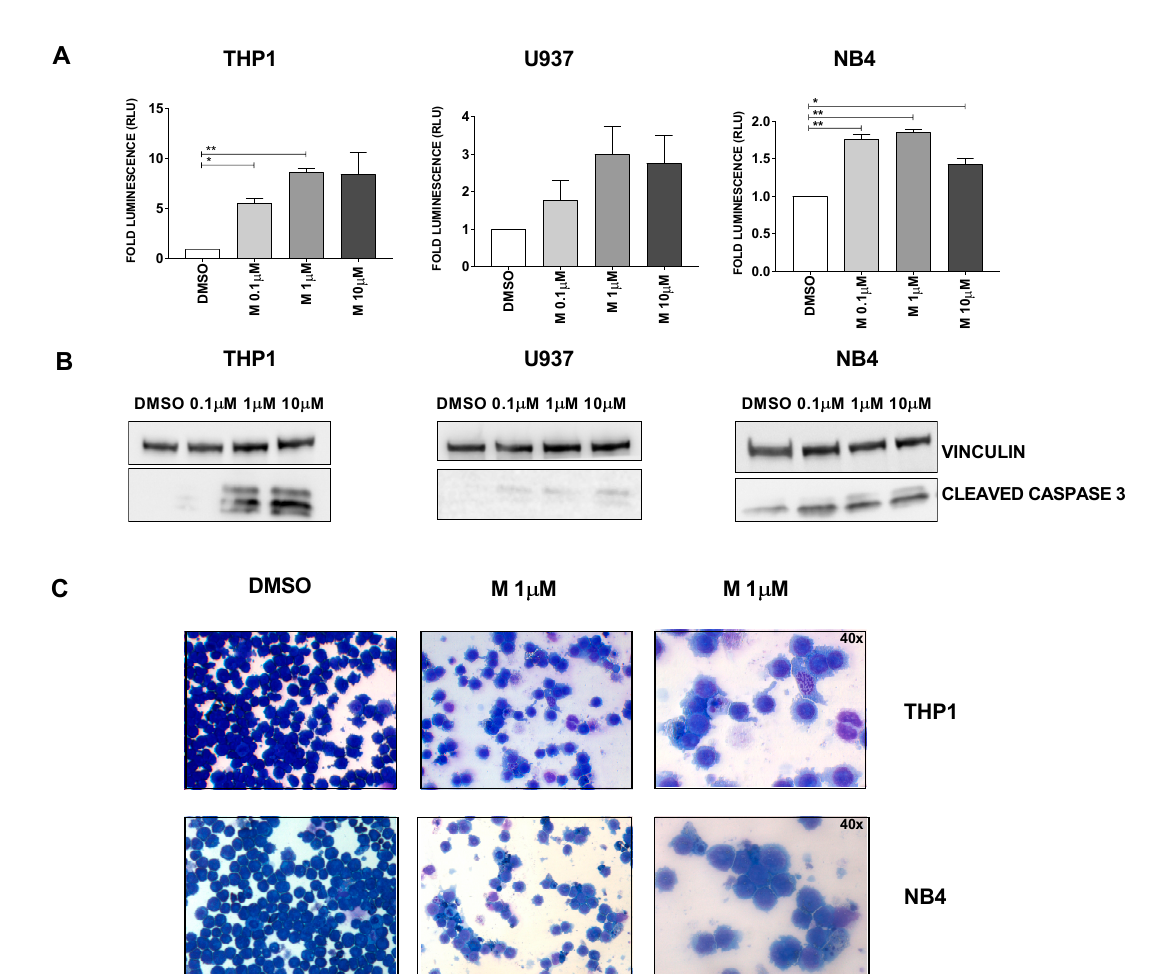
Figure 2. MEDS433 induces apoptosis in several AML cell lines (II). ( A ) MEDS433 treatment increases the activity of caspases 3/7, as evaluated through a specific functional assay ( n = 3). ( B ) MEDS433 increases the levels of cleaved caspase 3 ( n = 3). ( C ) Morphologic evaluation (Wright–Giemsa staining) of untreated (left panel) and treated cells (middle and right panels, n = 3). Untreated cells form a conspicuous, monomorphic population, with strongly basophilic appearance. After treatment with MEDS433, the population is significantly reduced; cells are extremely heterogeneous, with both signs of apoptosis (cytoplasmic vacuolation, karyopyknosis and karyorrhexis) and differentiation (decreased nuclear-cytoplasmic ratio and enlightening of the cytoplasm). If not otherwise specified, the magnification is 20×. Analyses were performed after 3 days of treatment. DMSO: dimethyl sulfoxide only. Statistical significance: t -test, * p < 0.05; ** p < 0.01.